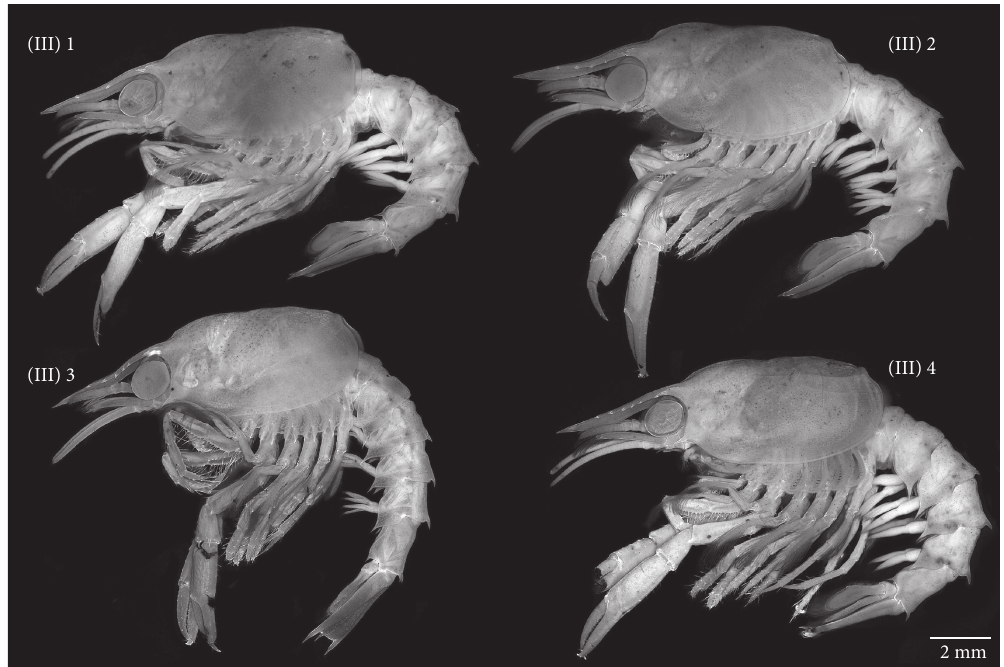
Figure 2: Additional specimens of larval stage (III). These show a certain degree of